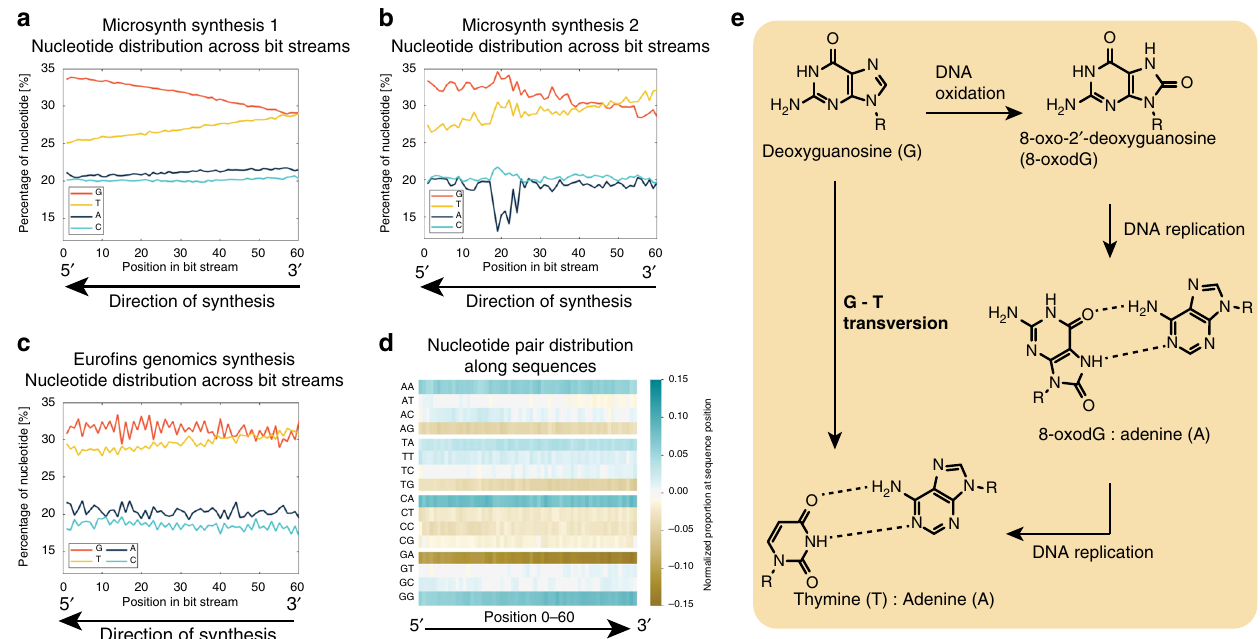
Fig. 3 Commercial DNA syntheses. Commercial DNA synthesis of random nucleotides from a Microsynth (synthesis 1), b Microsynth (synthesis 2), c Euro fi ns Genomics. d Heat map showing normalized nucleotide pair distribution along the strand length of Microsynth 1 synthesis (Fig. 3a). For the three syntheses, illustrated are the 60 nucleotides of the random section of DNA strands, respectively, based on the design featured in Fig. 1. The direction of synthesis is indicated by arrows. Analyzed sample size ca. 700,000 sequences each. e The mechanism of G – T transversion can be a source for the effect of percentage variation of G and T along the strand of DNA (position nonequivalence). Source data are provided in the Source Data fi